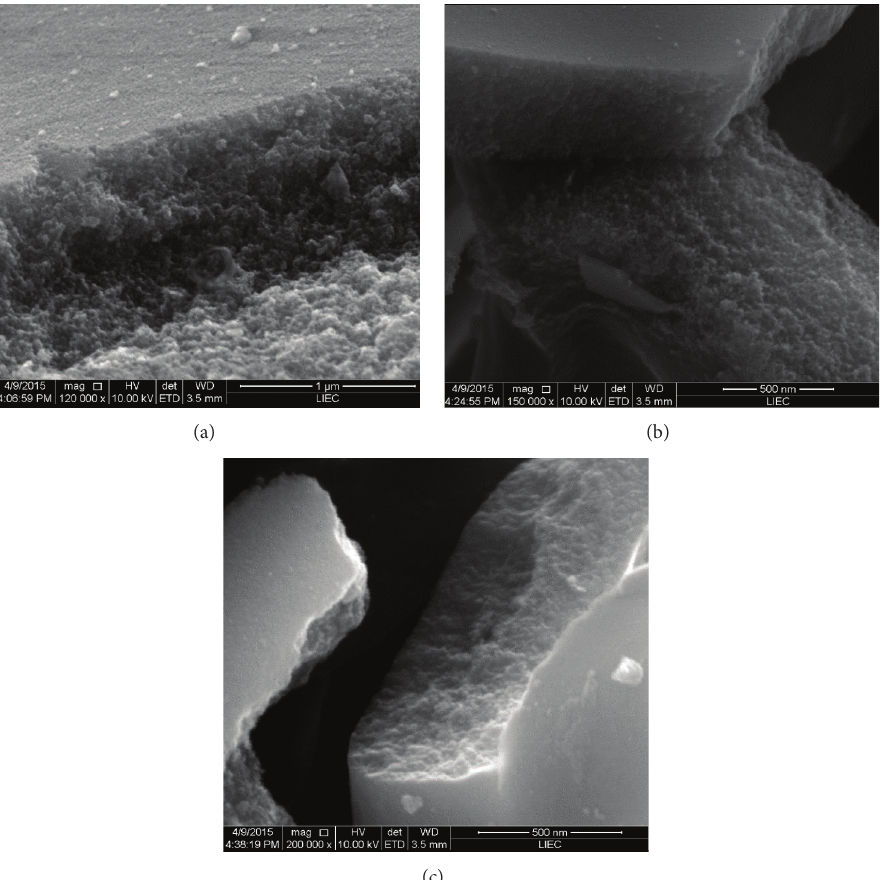
Figure 1: FESEM images of the TiO 2 nanoparticles: (a) SAM 01; (b) SAM 02; (c) SAM